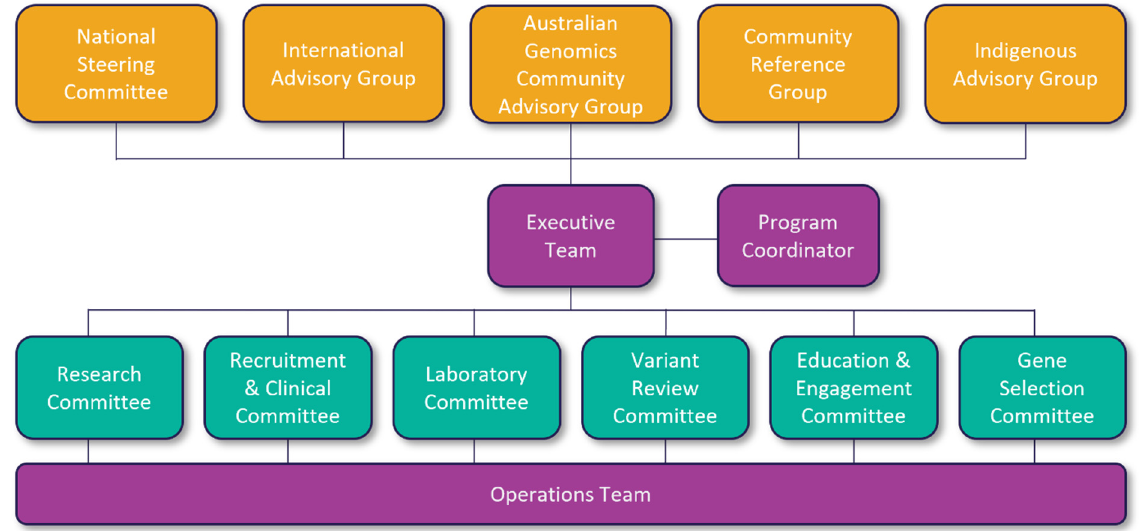
Figure 1. Mackenzie’s Mission’s governance structure.